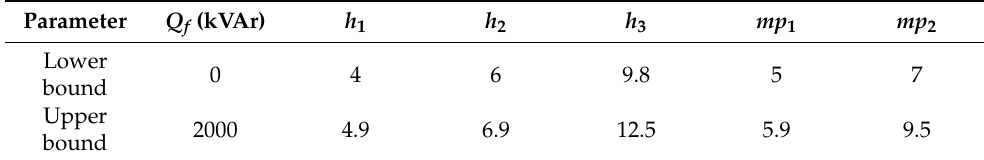
Table 2. The parameters’ search